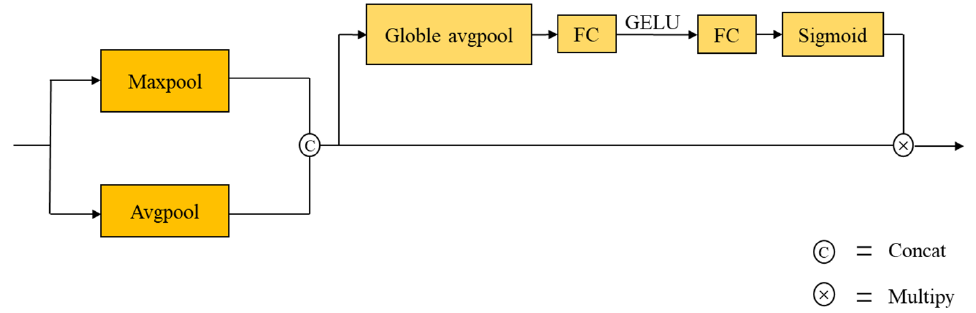
Figure 7. The structure of DPCI_SE Block.